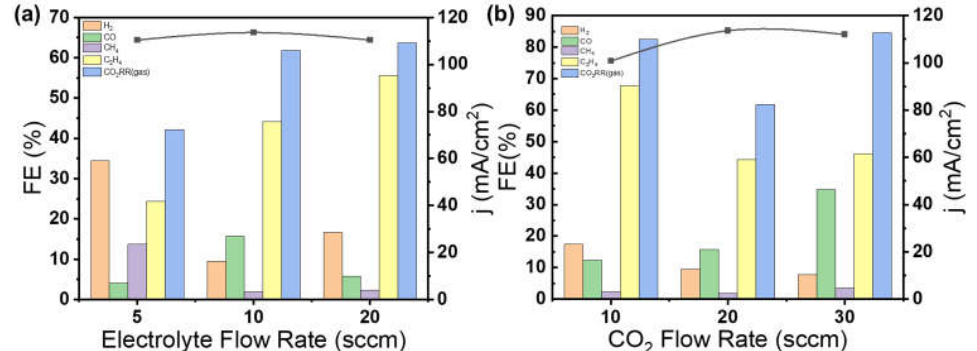
Figure 7. ( a ) The Faraday efficiency of gas products and current density at different electrolyte flow rates. Operating parameter: Cell voltage 4.2 V, CO 2 gas flow rate of 20 sccm, the anion exchange membrane of Sustainion X37-50 Grade T, and the channel type of parallel microchannel structure; ( b ) the Faraday efficiency of gas products and current density at different CO 2 flow rates. Operating parameter: Cell voltage 4.2 V, anolyte flow rate of 10 sccm, the anion exchange membrane of Sustainion X37-50 Grade T, and the channel type of parallel microchannel structure.